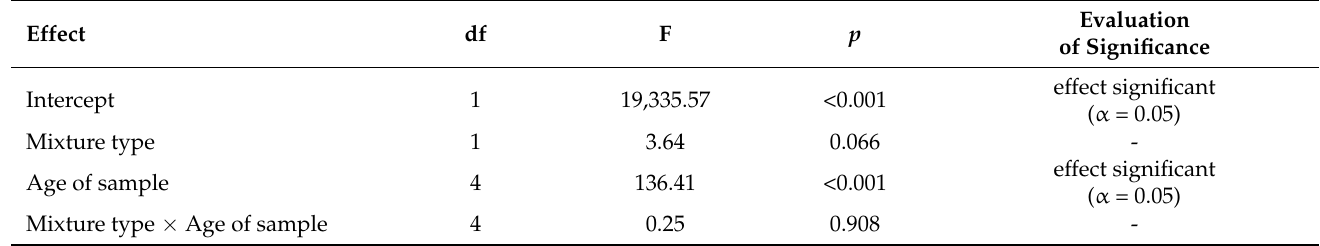
Table 14. Analysis of variance for the evaluation of the influence of Type of mixture and Age of samples on the unconfined compressive strength value UCS of the samples from REF-Mix and RCC-Mix with the use of ANOVA analysis.